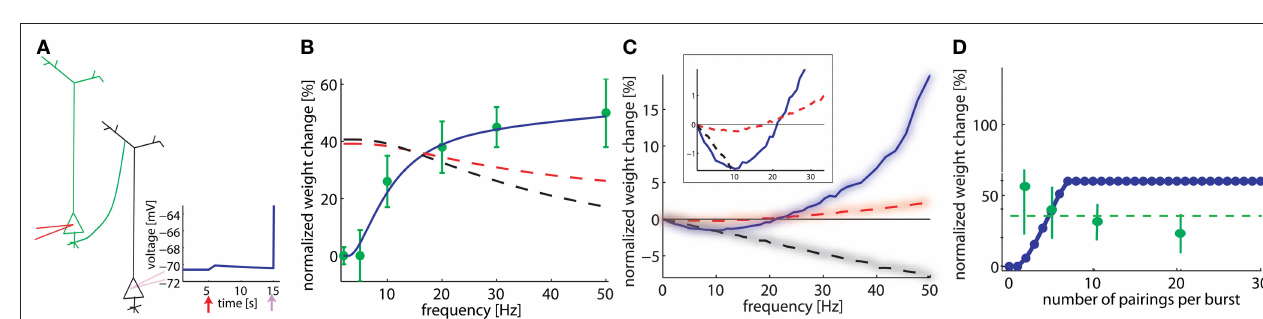
contribute; red dashed line: only pairs between the nearest spikes contribute to plasticity). (C) The frequency dependence is different, if both pre- and postsynaptic spikes are generated by a Poisson process (box: zoom). (D) The total amount of plasticity depends on the number of pre-post pairings at 2 ms lag. At least two pairs at 20 Hz are necessary. With our set of parameters, saturation at the maximal weight occurs for around seven pairings (model is blue, data redrawn from Senn et al. (2001) in green; in experiments, saturation is maybe already reached after two pairings, dashed green